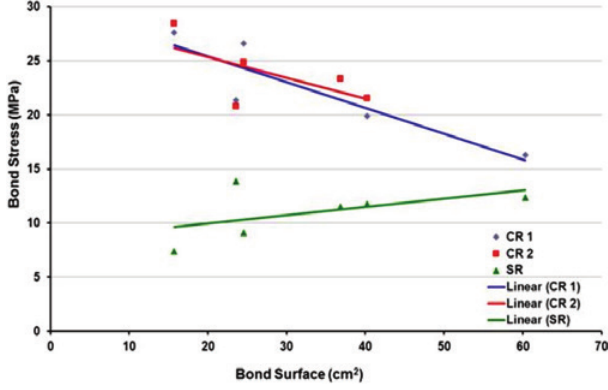
Figure 20 Bond Stress-Bond Surface, SR and CR models